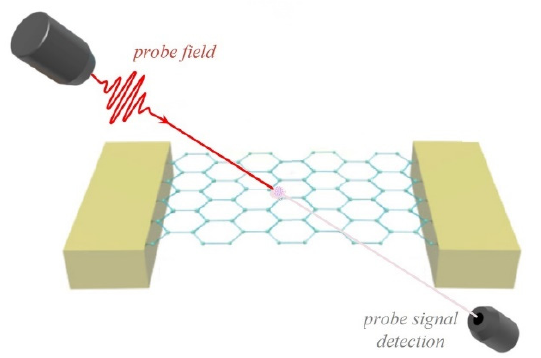
Figure 1. Schematic representation a doubly clamped suspended monolayer Z-shaped graphene nanoribbon nanoresonator coupled to an exciton while interacting with a probe electromagnetic field.